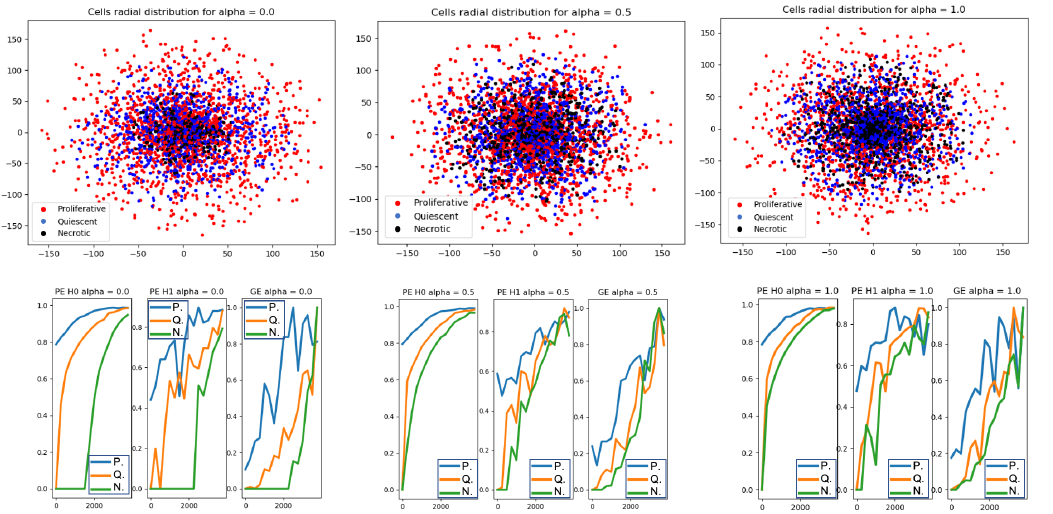
Figure 3. ( Top ) radial cell displacement for different α = [ 0.0,0.5,1.0 ] . In red: proliferative, blue: quiescent, black: necrotic. ( Bottom ) Corresponding temporal evolution of Persistent Entropy for H0 and for H1 and Generator Entropy for the same α : for proliferative cells (blue), quiescent cells (orange) and necrotic cells